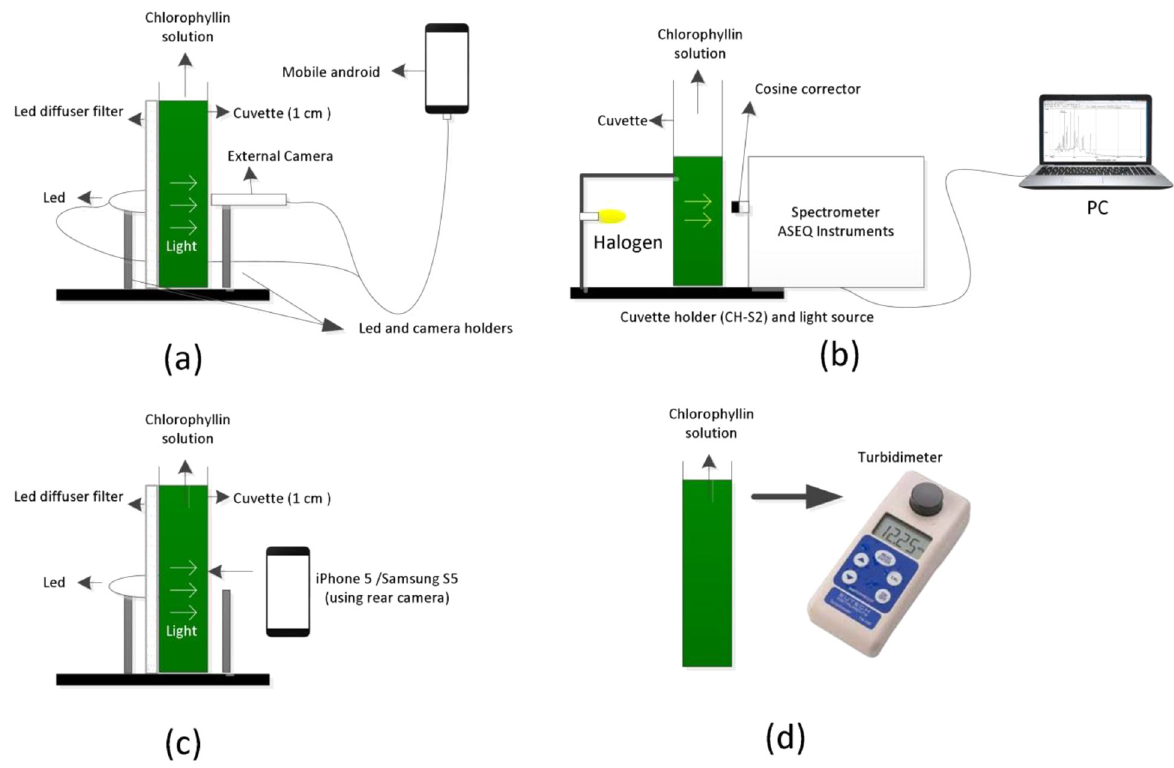
Fig. 1. Different methods of hydro color measurement using (a) low-cost external camera with a custom android application; (b) spectrometer; (c) iPhone/Samsung camera; (d)